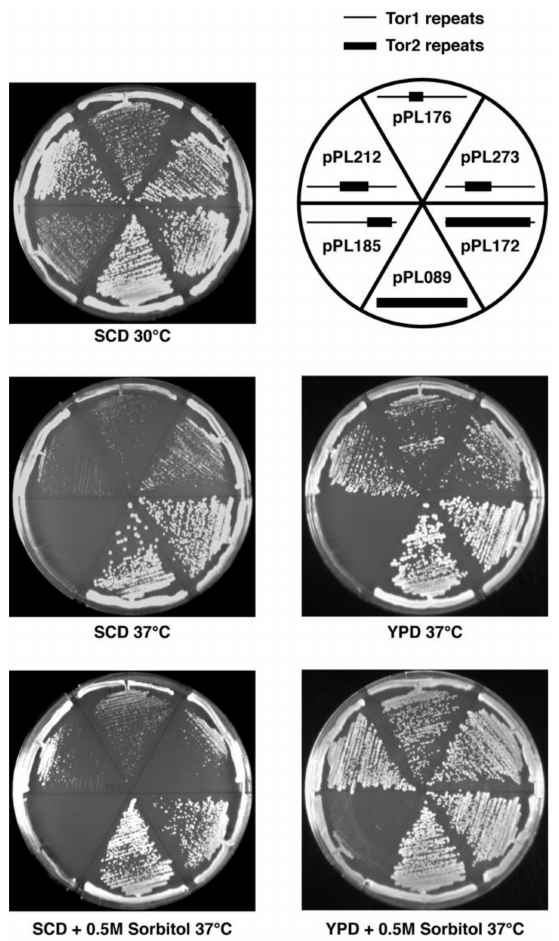
Figure 2. Phenotypes of selected chimeras in tor2 ∆ cells on solid medium. Plates contained the indicated media and were grown for 2 days at the indicated temperatures and then photographed. Legend depicts chimeras tested on the corresponding plates. Schematic indicates N-terminal Tor2 (heavy lines) versus Tor1 (thin lines) regions in each